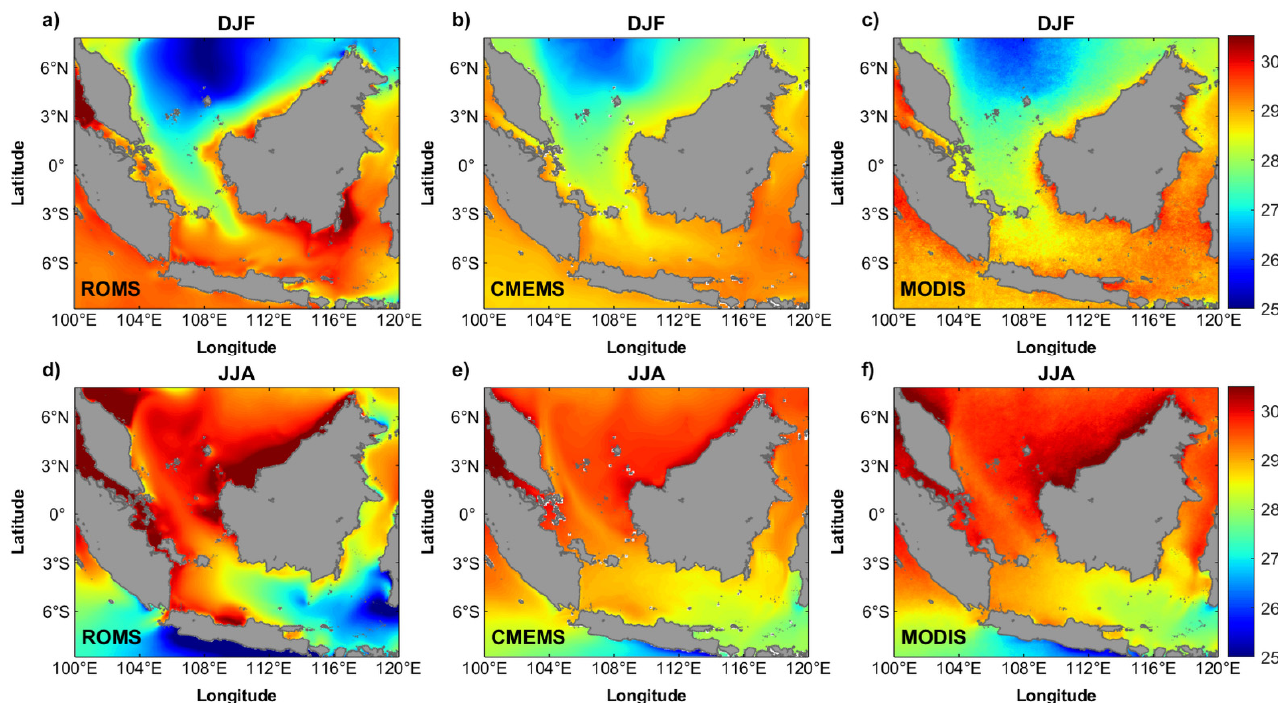
Figure 5. Seasonal SST (unit: °C) climatology during the ( a – c ) boreal winter and ( d – f ) boreal summer derived from ROMS ( left panel), CMEMS ( middle panel), and MODIS ( right panel).